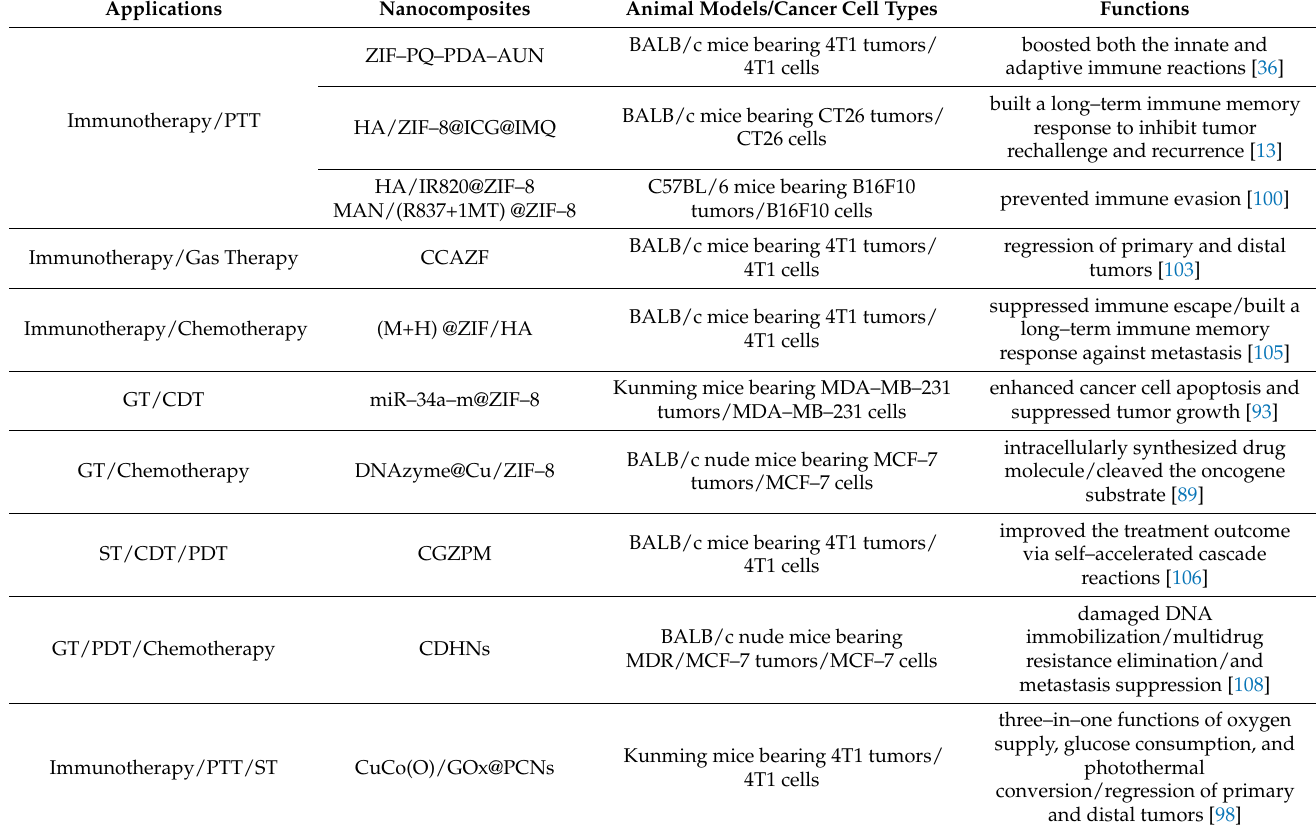
Table 3. Recent research on ZIF–8–based nanoplatforms for combination cancer